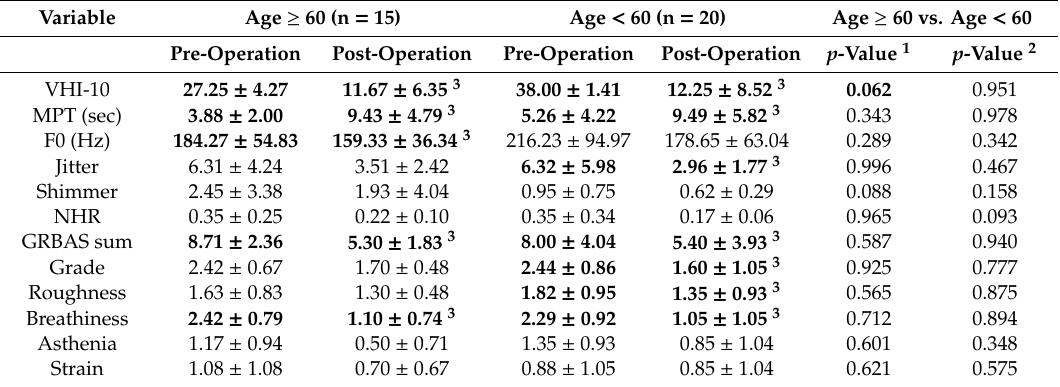
Table 3. Comparison of all parameters between the age ≥ 60 and age < 60 subgroups.